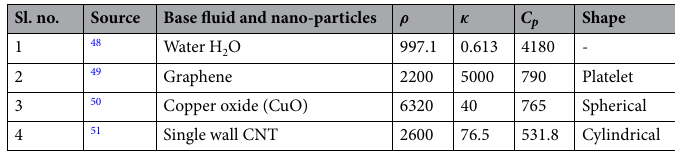
Table 1. Thermo-physical properties 48–51